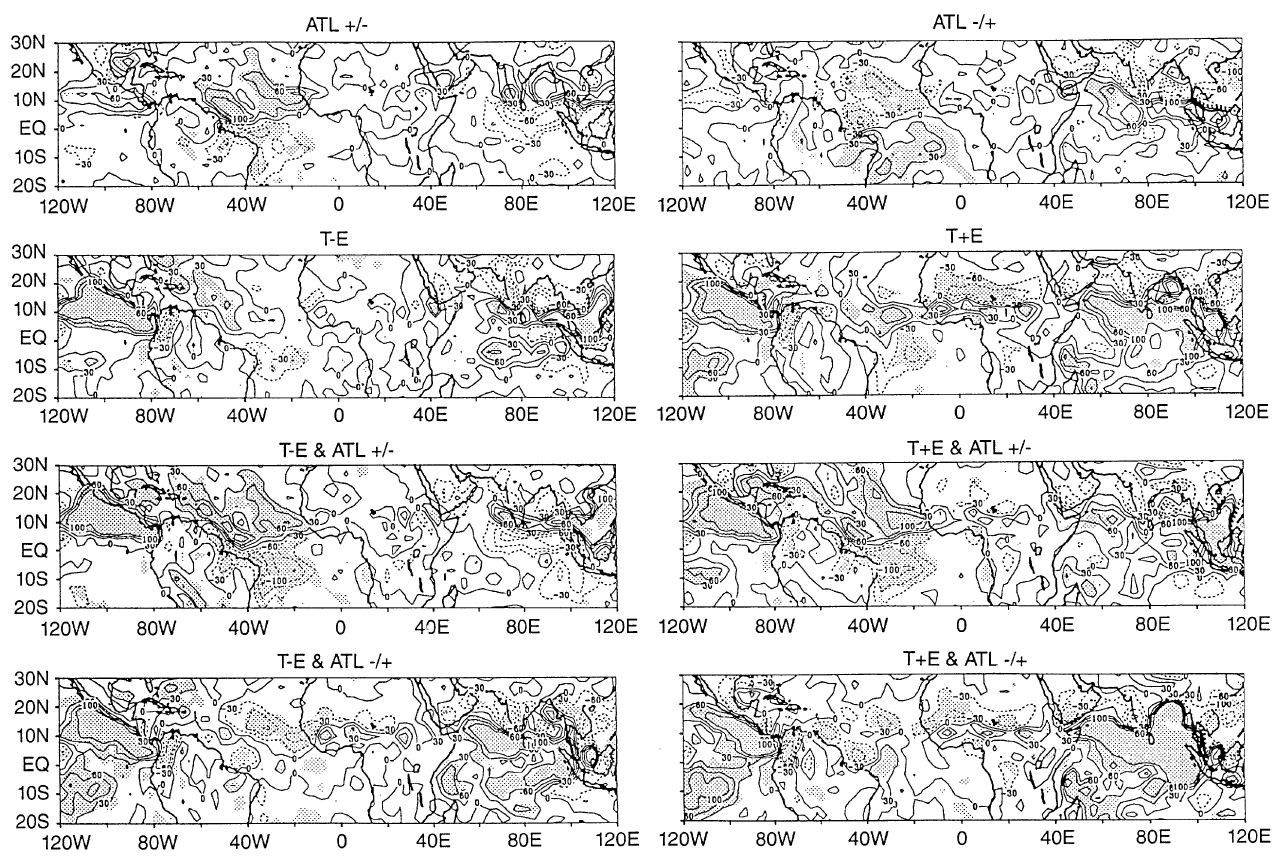
100 mm per month (resp. ! 30, ! 60, ! 100) in solid (resp. dashed ) line . Anomaly areas significant at the 5% level are shaded